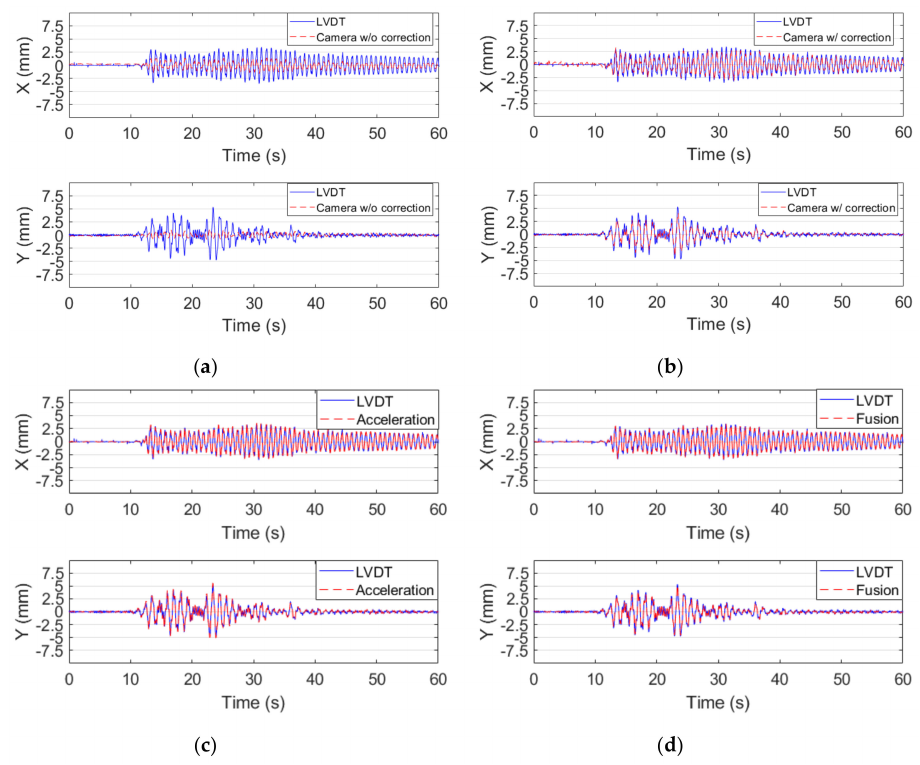
Figure 10. Time histories of interstory drift during the El Centro earthquake excitation with a peak ground acceleration (PGA) of 50 gal measured by: ( a ) the camera without correction; ( b ) the camera with correction; ( c ) acceleration; and ( d ) the camera fused with the accelerations. (upper: X-direction and lower: